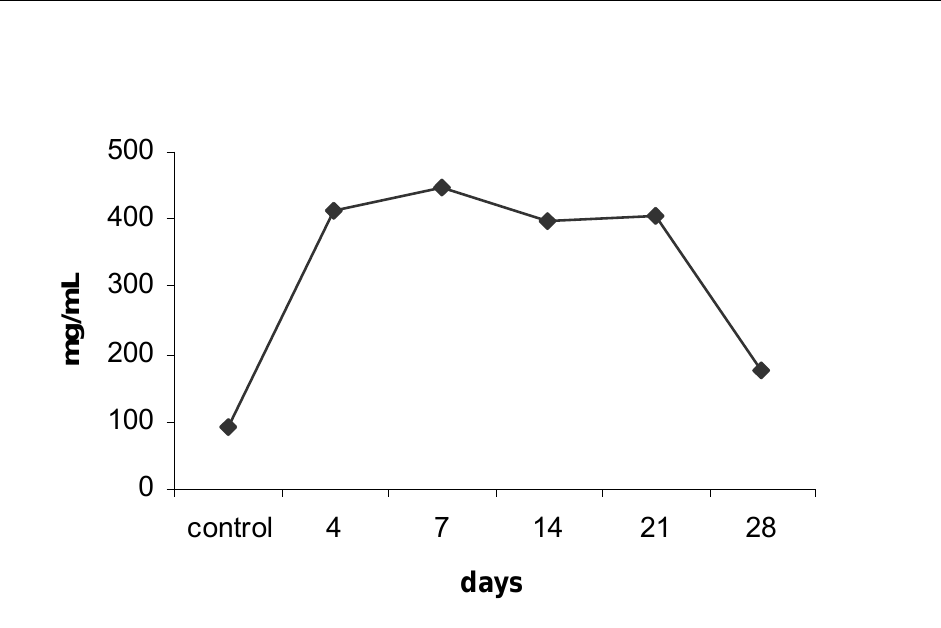
Figure 5. Protein levels present in brochoalveolar lavage fluid of hamsters infected with Leptospira interrogans serogroup Icterohaemorrhagiae and controls.